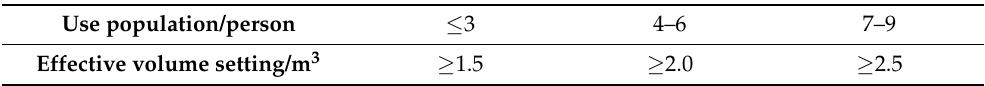
Table 5. Effective volume of septic